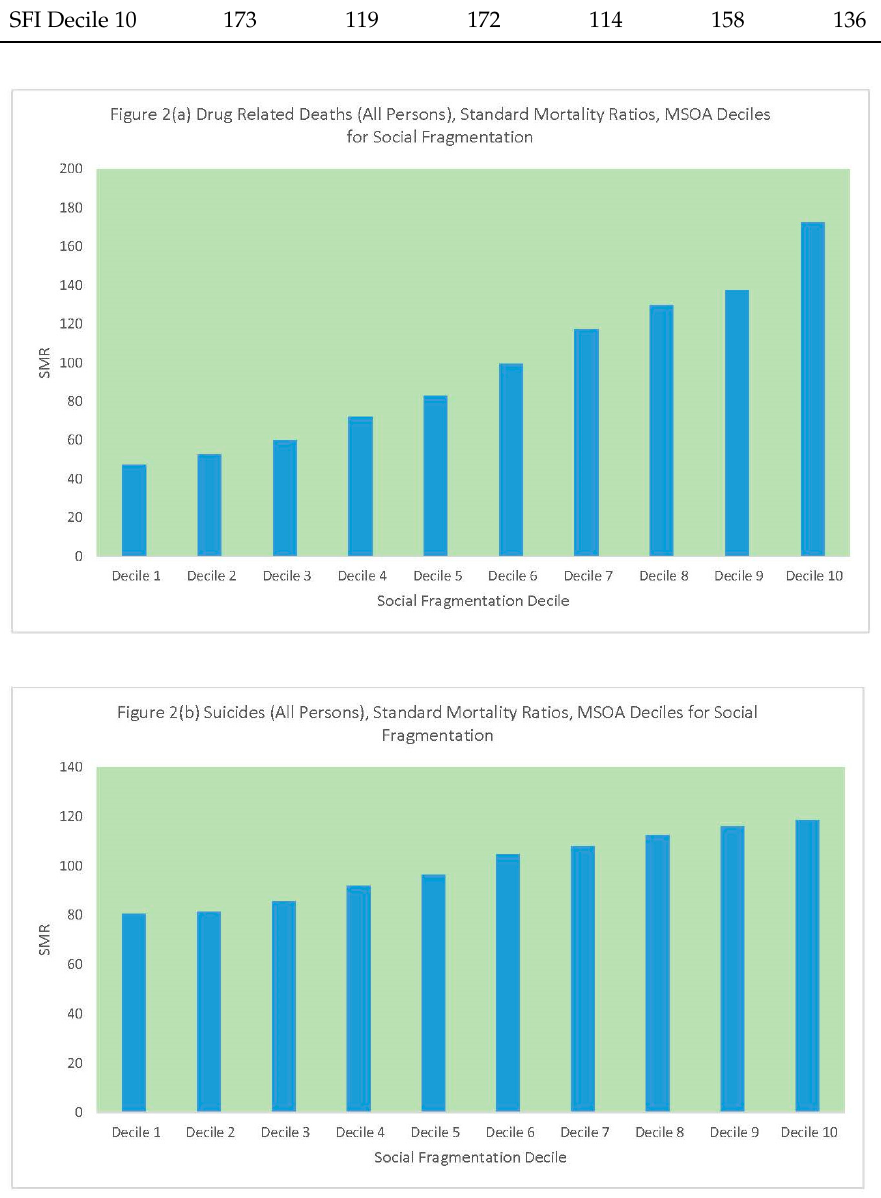
Figure 2. ( a ) DRD SMRs by MSOA Fragmentation Decile, ( b ) Suicide SMRs by MSOA Fragmentation Decile.